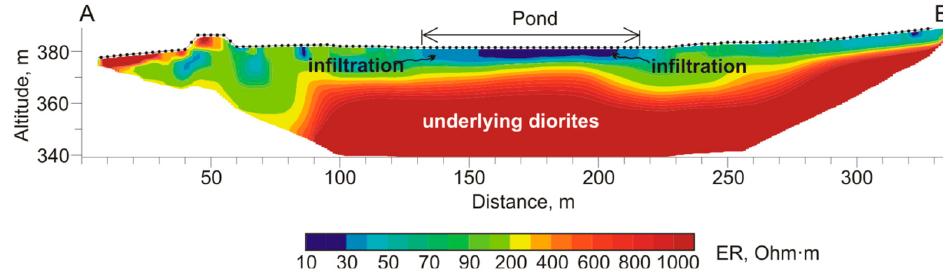
Figure 2. The geoelectric section through Komsomolsk tailings pond along line A–B (Figure 1).